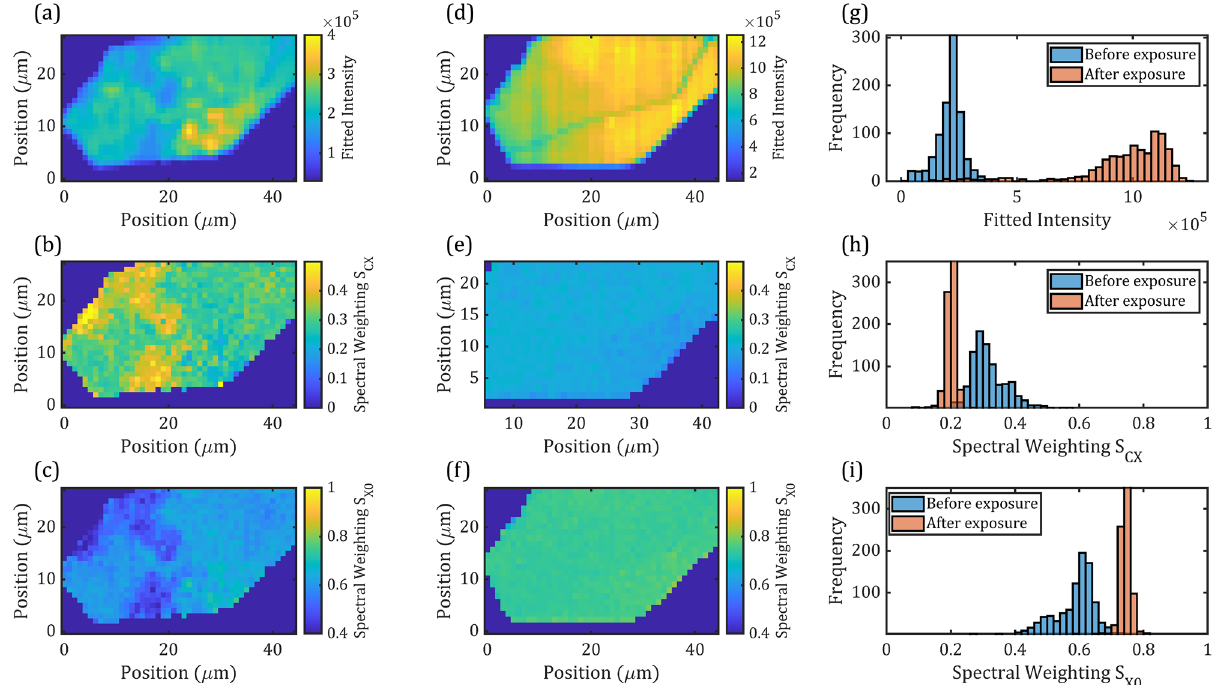
Figure 5. Maps and statistics from large area WS 2 flake illuminated with high power ( I L = 78 kWcm −2 , 10 s) laser in raster-scan. PL maps are acquired before ( a ) and after ( d ) the laser illumination, S CX and S X 0 maps were extracted from modelling the PL maps both before ( b , c ) and after ( e , f ) the laser illumination. Histograms of the PL peak intensity ( g ), charged exciton ( h ) and exciton ( i ) spectral weightings before and after the laser illumination are then